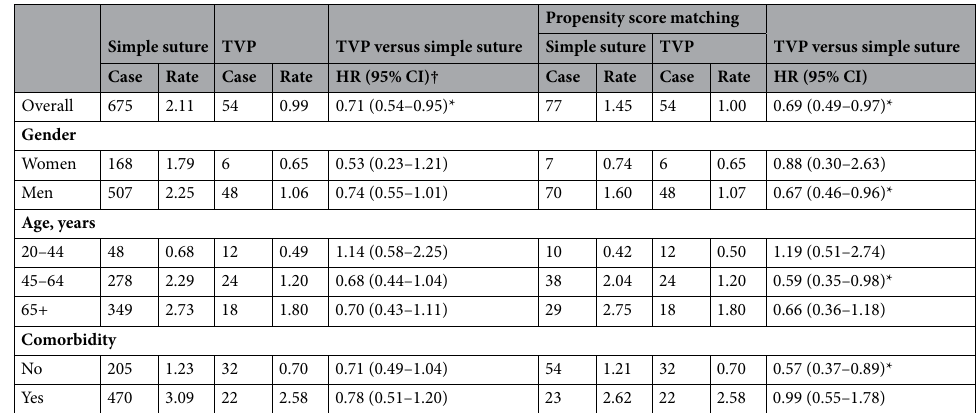
Table 2. Risk of subsequent liver and intrahepatic cancer in non-HP infected PPU patients with simple suture and TVP. Rate, per 1000 person-years. HR hazard ratio, CI confidence interval, HP helicobacter pylori, PPU perforated peptic ulcer, TVP truncal vagotomy and pyloroplasty. † Multivariable model, adjusted for age, gender, diabetes, cirrhosis, hypertension, hyperlipidemia, and stroke. * p <